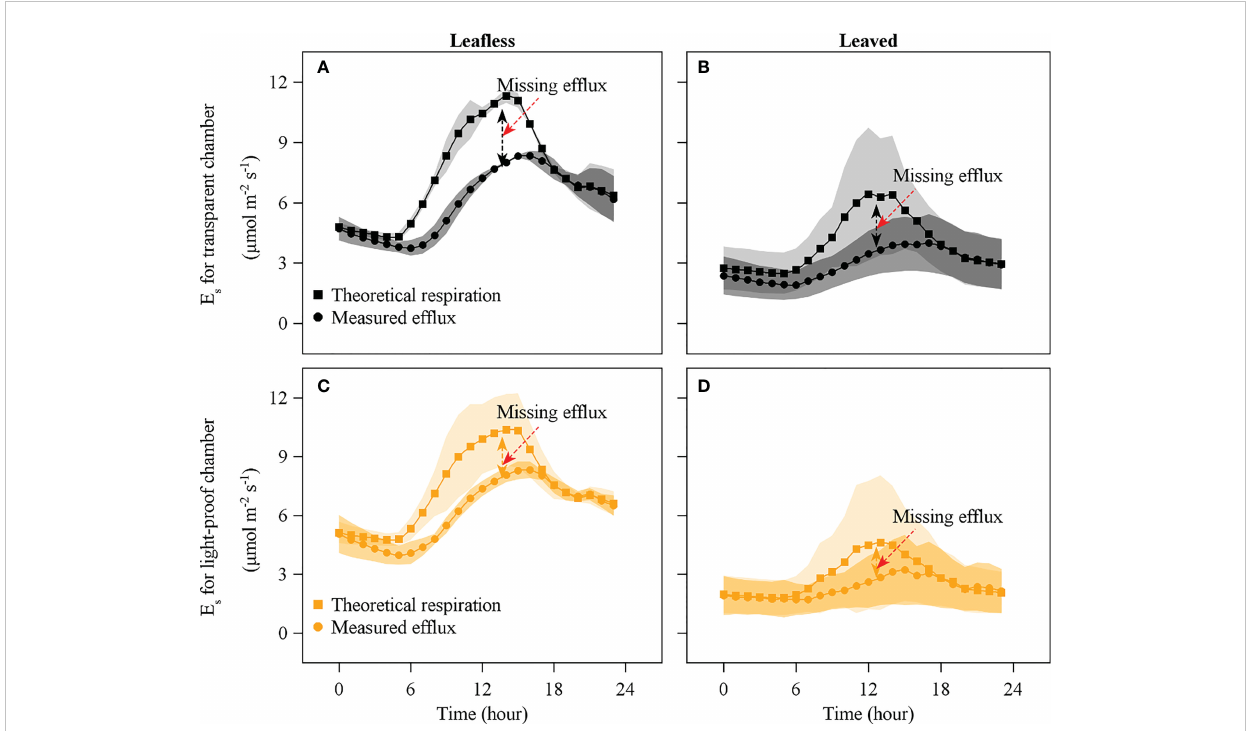
FIGURE 7 Comparison of theoretical respiration (squares) and measured ef fl ux (dots) with transparent (black) and light-proof chambers (orange) in lea fl ess (A) , (C) and leaved (B) , (D) stages. Note that E s is the CO 2 ef fl ux released from the culm surface, and missing ef fl ux is the difference between the theoretical respiration and E s